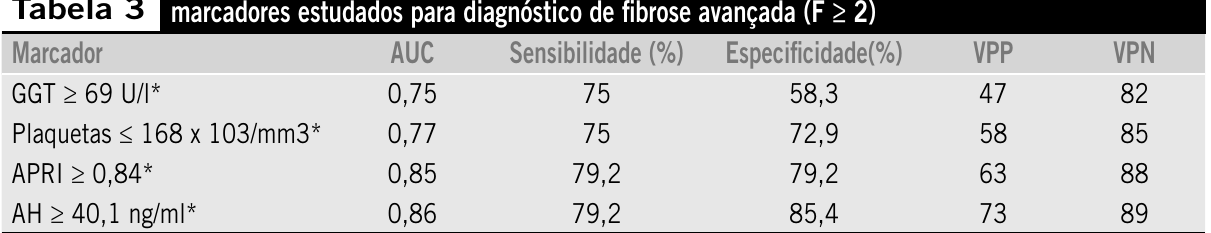
Área sob a curva RoC, sensibilidade, especificidade, valores preditivos positivo e negativo dos marcadores estudados para diagnóstico de fibrose avançada (F ≥ 2)